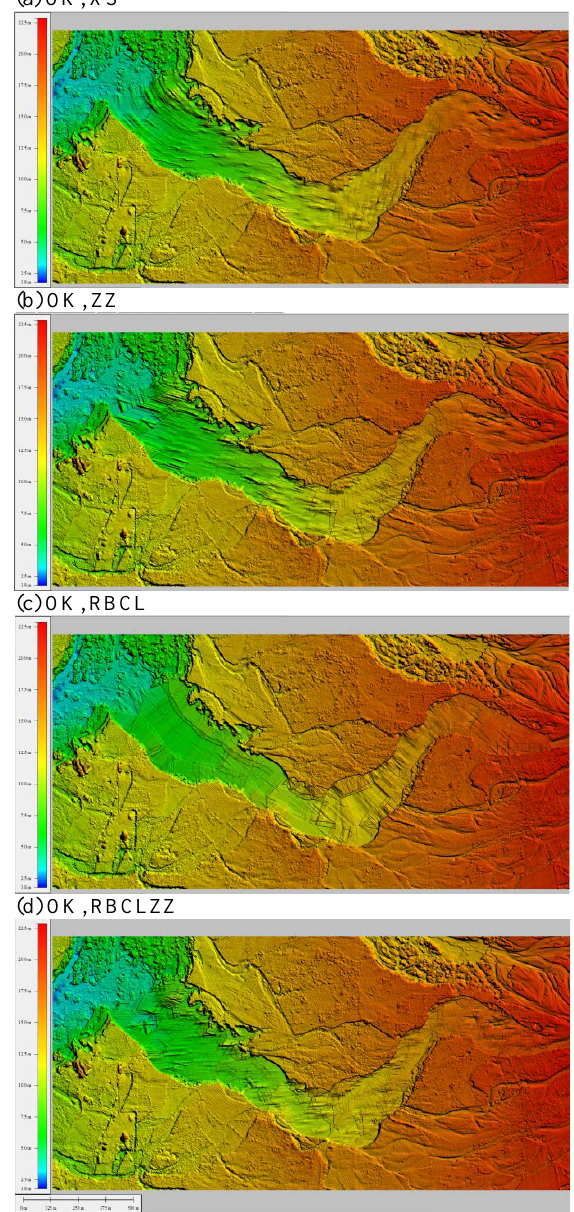
Figure 5. Results of Ordinary Kriging (OK)